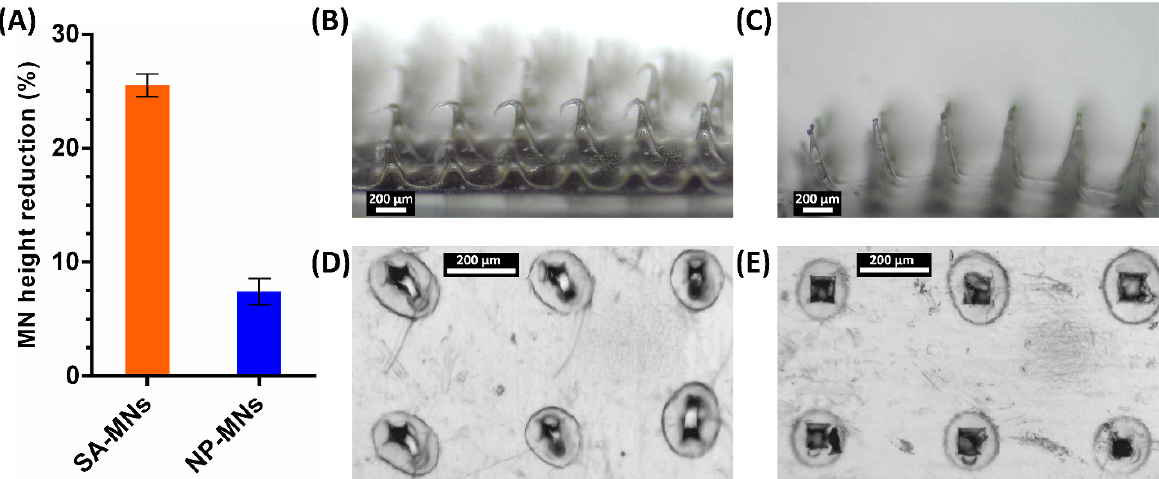
Figure 7. Insertion test in the parafilm skin simulant model. MN height reduction for MNs after insertion test using the parafilm skin simulant model ( A ), results expressed as means ± s.d., n = 10. SA-MNs ( B ) and NP-MNs ( C ) acquired with the optical microscope after the insertion test. Repre- sentative microscopic images of the first layer of parafilm into which SA-MNs ( D ) and NP-MNs ( E ) were inserted.